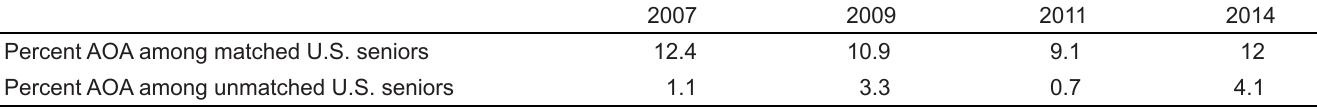
Table 4. AOA medical society status among U.S. seniors pursuing a match in emergency